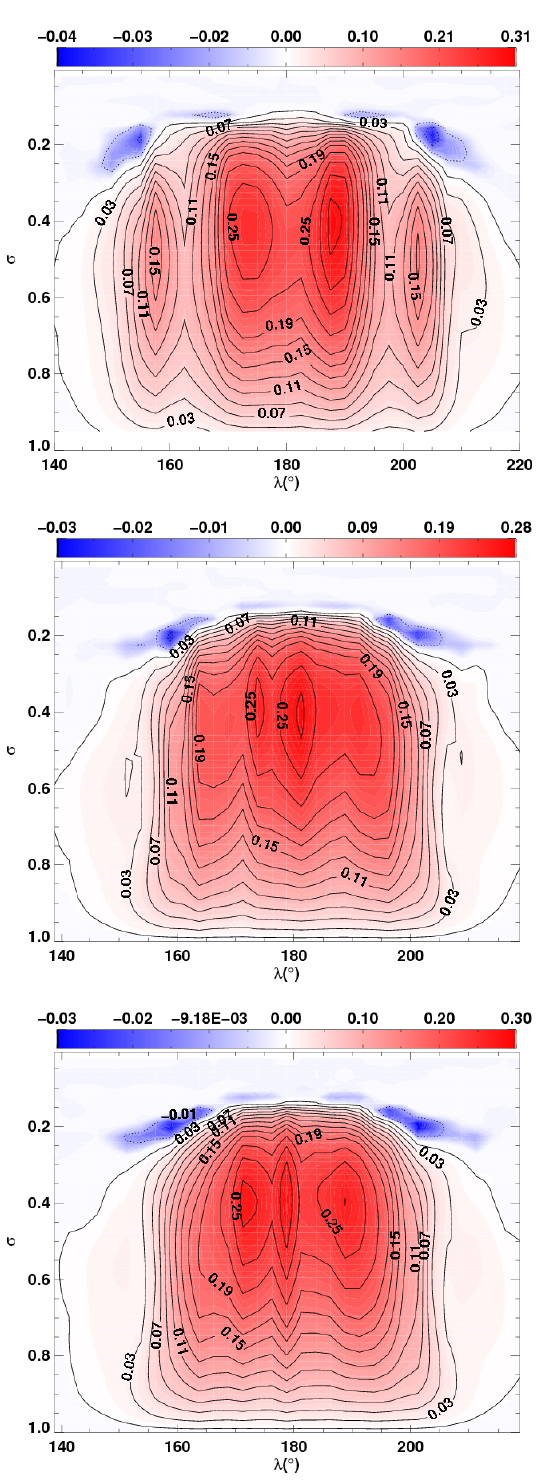
Figure 17. Figure showing, for the tidally locked Earth test (Merlis and Schneider, 2010; Heng et al., 2011b), the temporally averaged Fig. 17. Figure showing, for the Tidally Locked Earth test (Merlis vertical velocities (ms − 1 ) over the “hot spot” or subsolar point for and Schneider, 2010; Heng et al., 2011b), the temporally averaged the ND (top panel), EG sh (middle panel) and EG (bottom panel) vertical velocities (ms − 1 ) over the ‘hot spot’ or subsolar point for models (see Table 2 for explanation of model the ND ( top panel ), EG sh ( middle panel ) and EG ( bottom panel ) models (see Table 2 for explanation of model types).